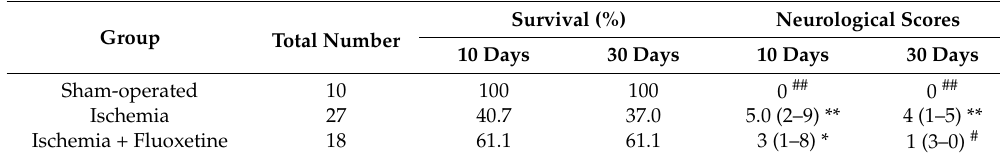
Table 1. Animal survival and neurological scores after surgery 1 .